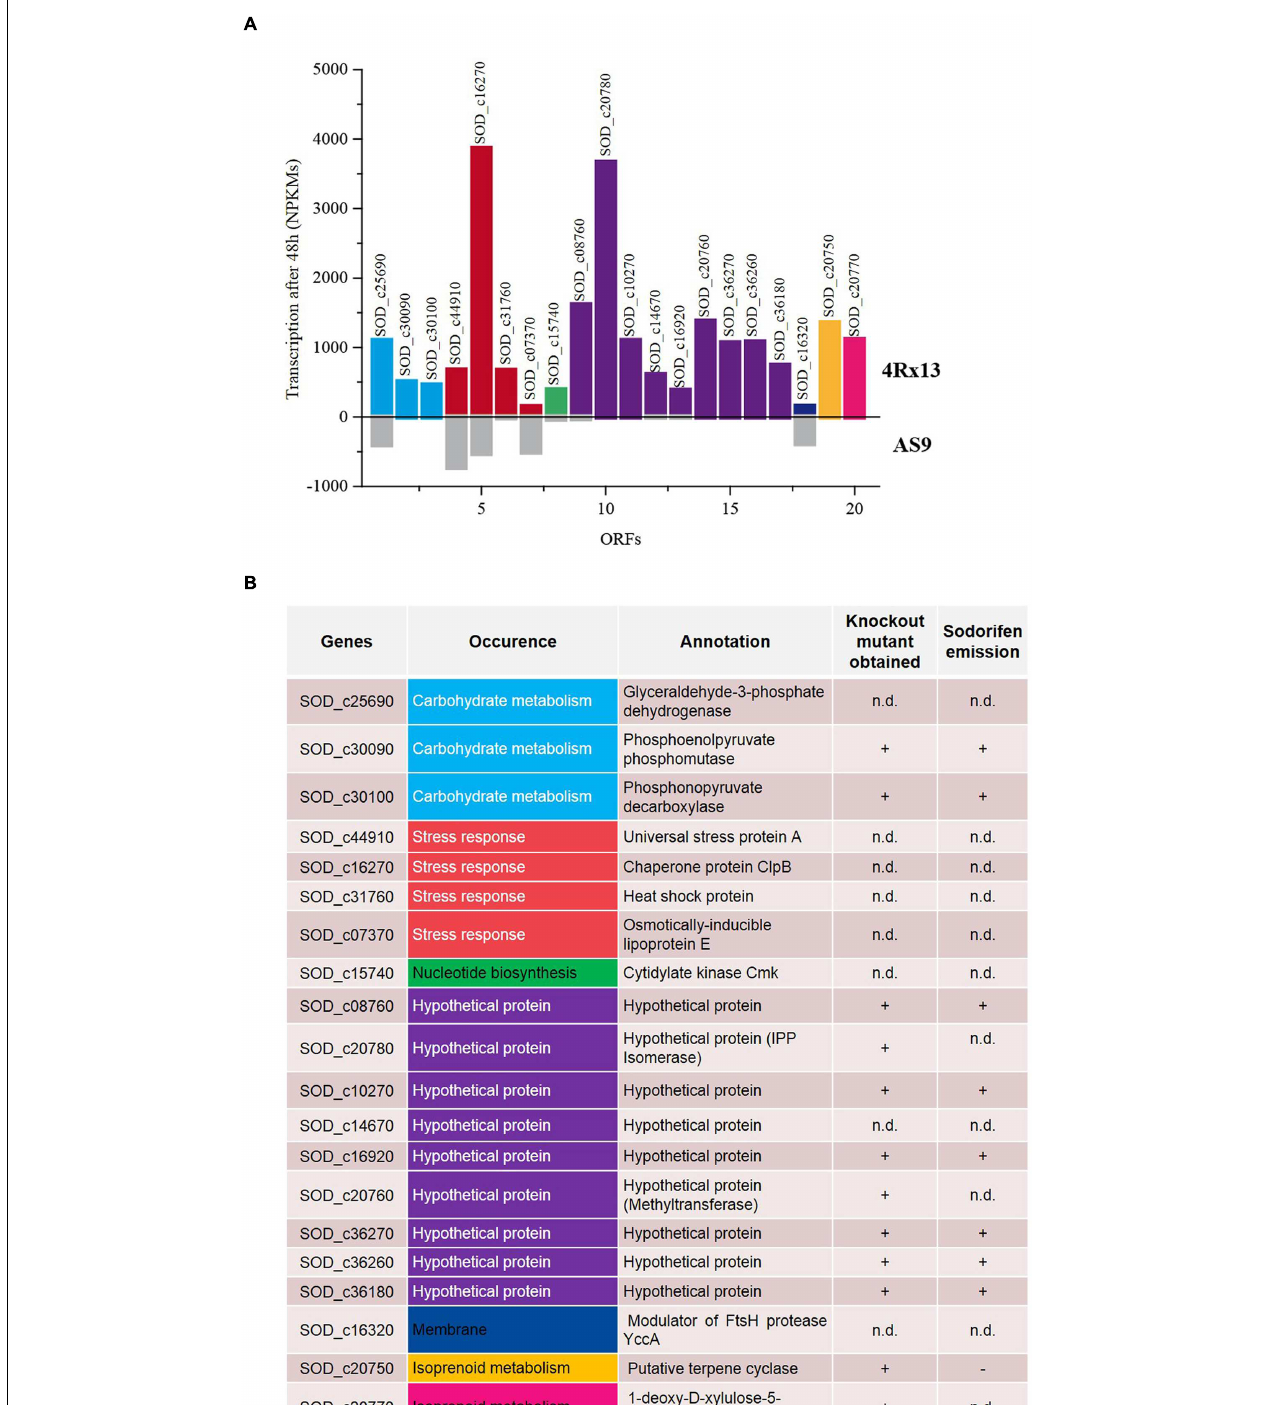
FIGURE 3 | Analysis of the transcriptomes of Serratia plymuthica 4Rx13 and AS9. Both bacterial isolates were grown over 48 h in minimal medium supplemented with succinate. Samples for RNA isolation were taken after 48 h, and mRNA was sequenced to determine the expression levels of genes. (A) Genes expressed in high levels in S. plymuthica 4Rx13 (colored bars, upper panel) and expressed at low levels or not at all in S. plymuthica AS9 (gray bars, lower panel). Transcription activity refers to nucleotide activities per kilobase of exon model per million mapped reads (NPKM). (B) Differentially expressed genes in S. plymuthica 4Rx13 and AS9 with their annotations are listed and corresponding metabolic pathways are indicated. Summarized are the knockout mutants performed so far and their respective sodorifen emission is indicated. n.d. not determined.